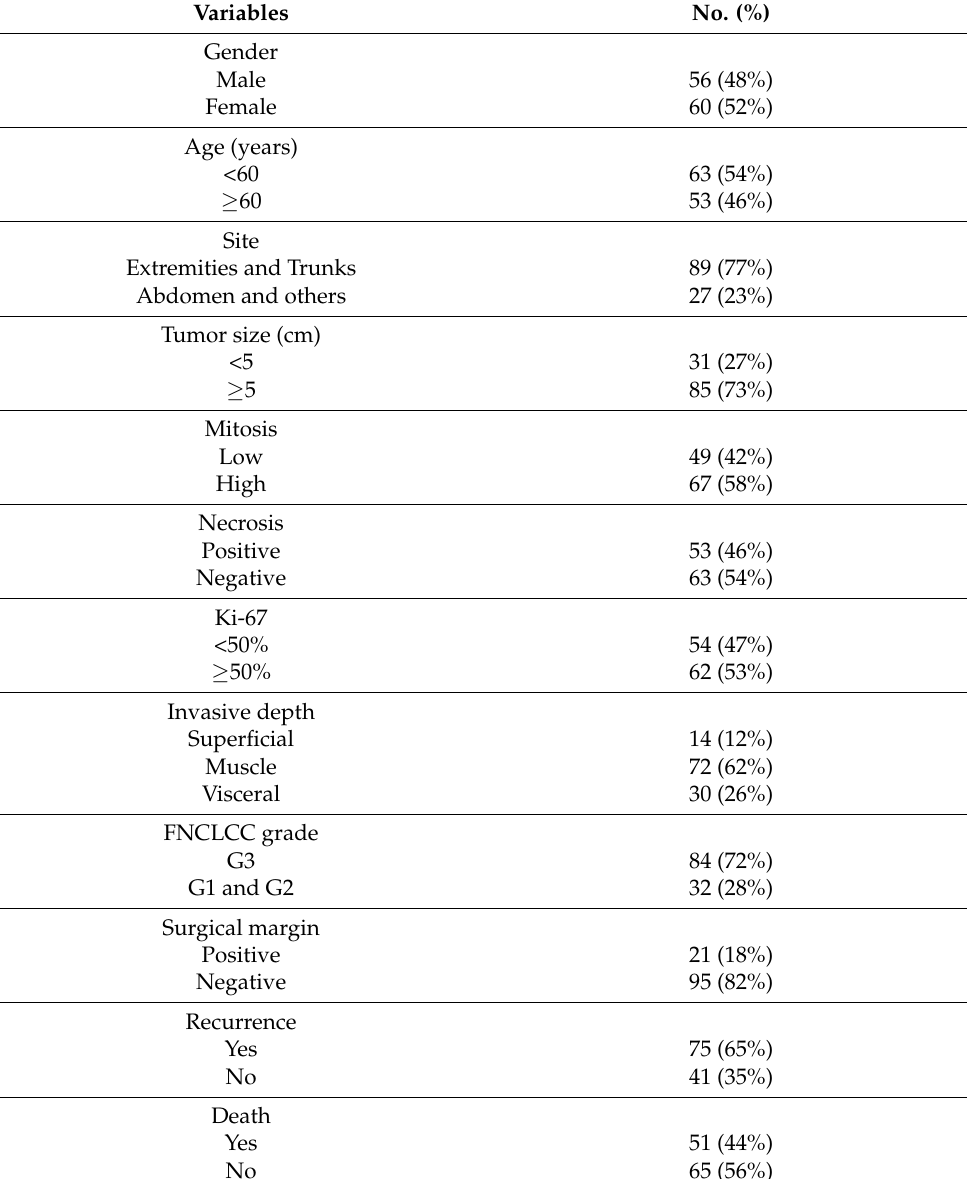
Abbreviation: FNCLCC: French Federation Nationale des Centres de Lutte Contre le